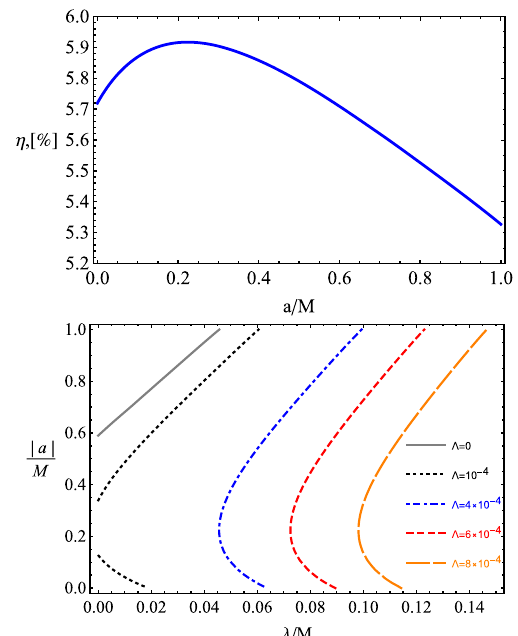
Fig. 8 DependenceoftheenergyreleaseefficiencyfromKerrBH’sret- rograde accretion disk from its spin parameter (top panel) and degen- eracy relations between spin of the Kerr BH and the DM parameter providing the same energy efficiency in the case when the matter rate down flow to central BH is equal in the two cases. In this plot, we use Λ → Λ/ M